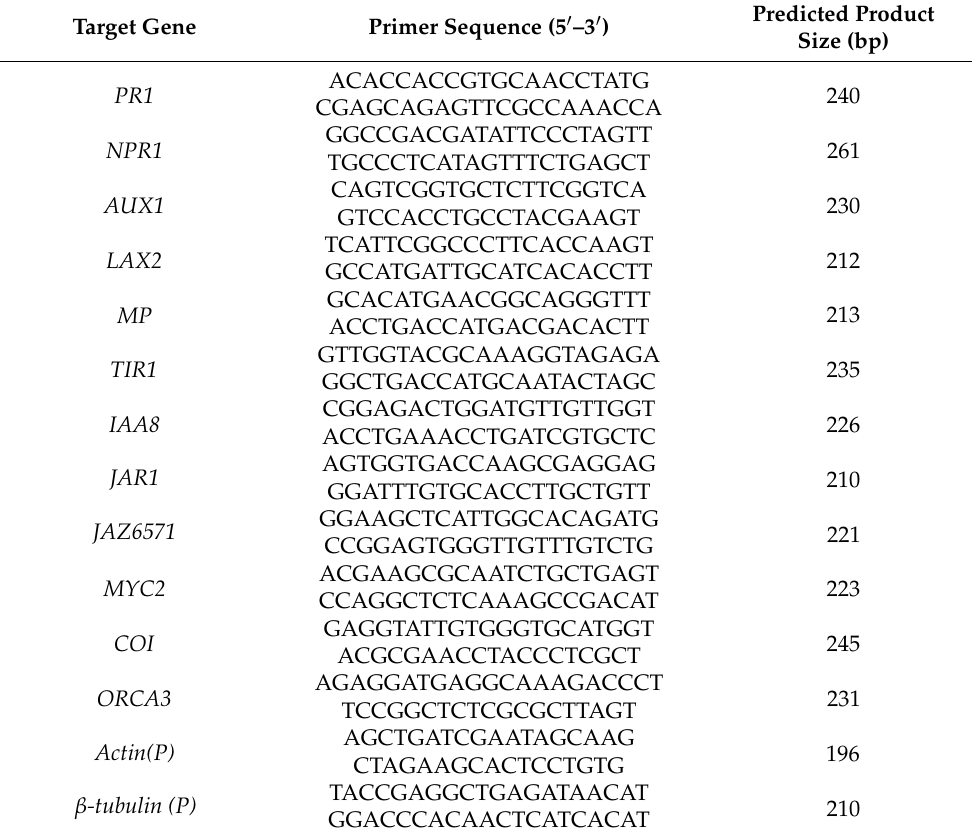
Table 1. Genes and primers used for the RT-qPCR analysis. Target